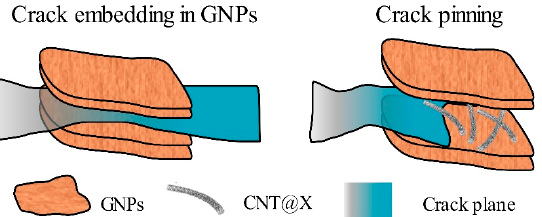
Figure 8. Fracture micrographs for different nanocomposite specimens under the quasi-static 3P- ENB loading condition.